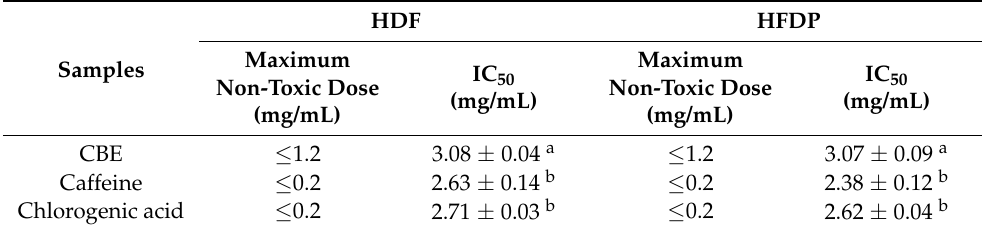
Figure 2. Cytotoxicity of various concentrations of CBE, caffeine, and chlorogenic acid on ( A ) HDF and ( B ) HFDP cells. Table 2. The maximum non-toxic dose and 50% inhibition concentration (IC 50 ) of CBE, caffeine, and chlorogenic acid on HDF and HFDP cells.